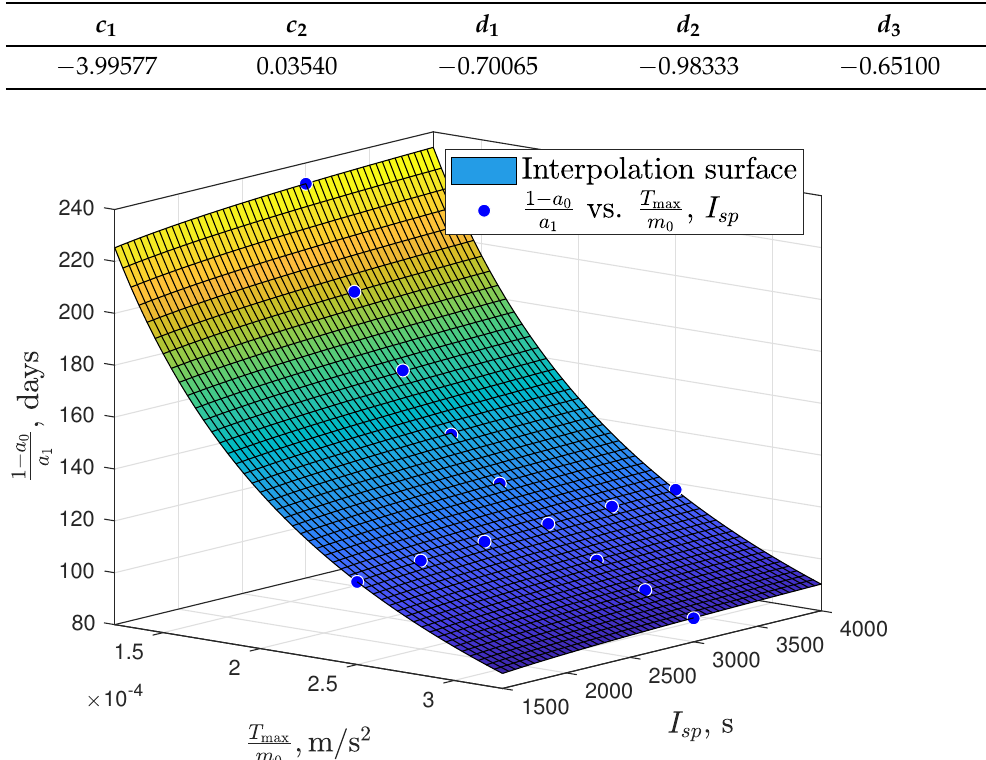
Figure 9. Interpolation surface and the real values of ( 1 − a 0 ) / a 1